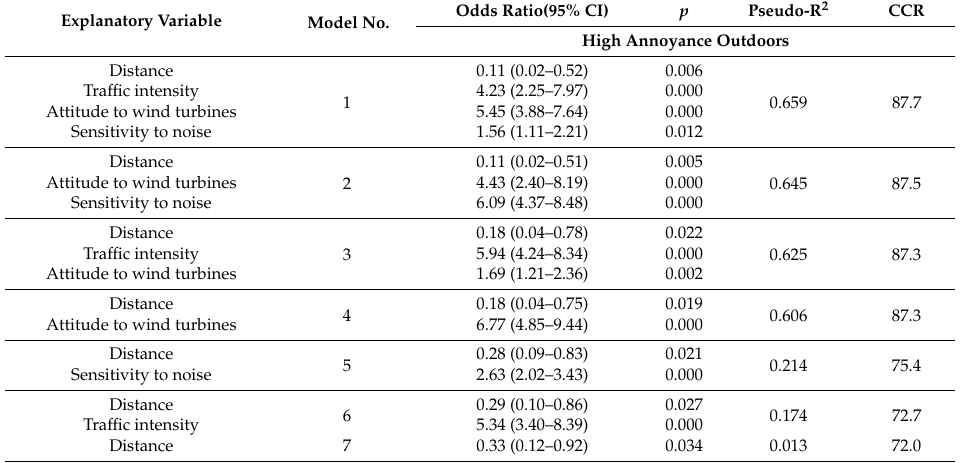
Table 10. Factors affecting the noise annoyance perception outdoors—results of logistic regression analyses 1